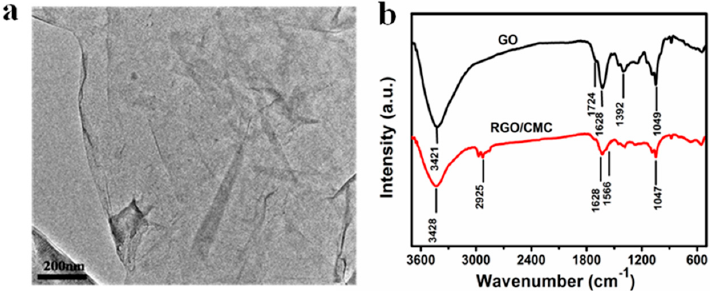
Figure 1. ( a ) A TEM image of RGO/CMC. ( b ) FT-IR spectra of GO and RGO/CMC.